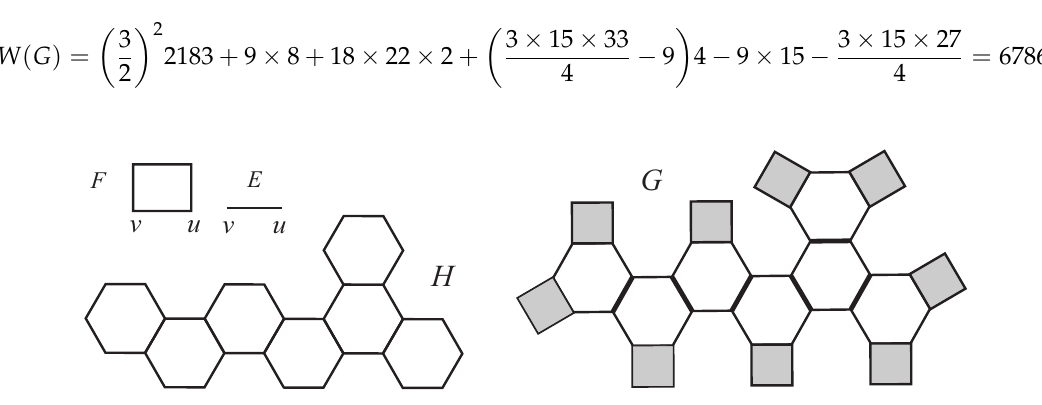
Figure 4. Attaching graph F to 2-edges of benzenoid graph H